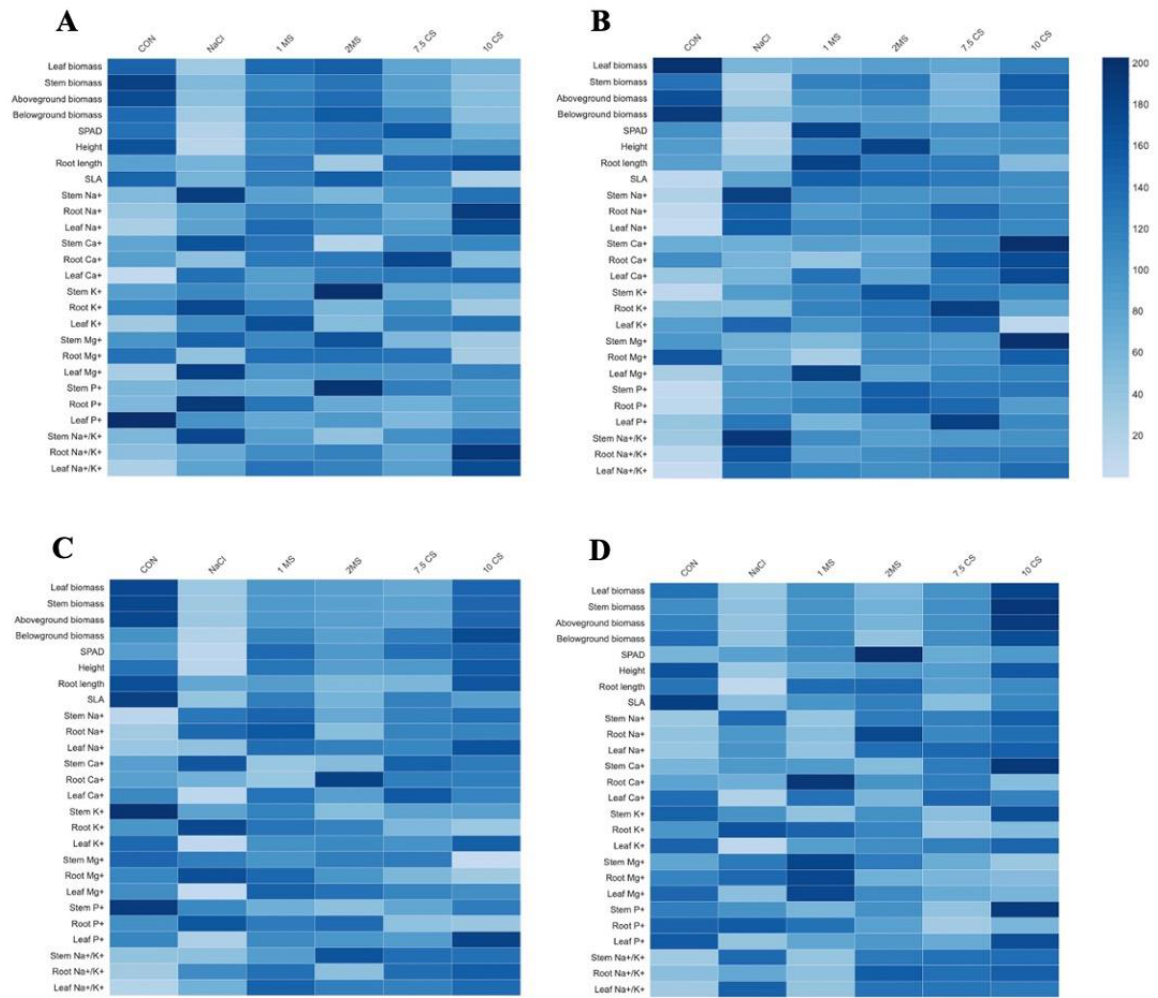
Figure 6. Heat map for morphological parameters and macronutrients under different treatments in T. pratense at ( A ) 60 DAT; ( B ) 120 DAT, and F. arundinacea ( C ) 60 DAT; ( D ) 120 DAT.